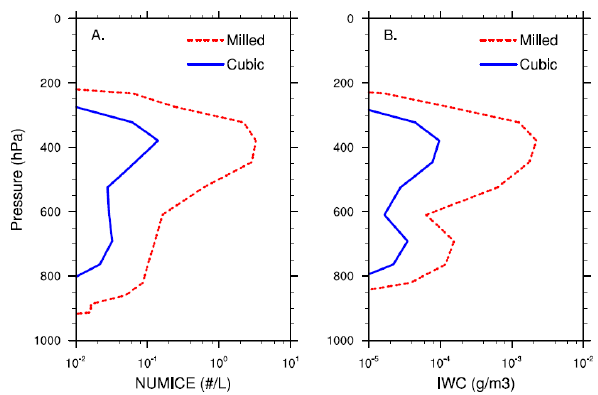
Fig. 5. Simulated monthly mean vertical profile of (A) ice crystal number concentration (L − 1 ) and (B) ice water content (gm − 3 ) over the ARM-SGP site in April